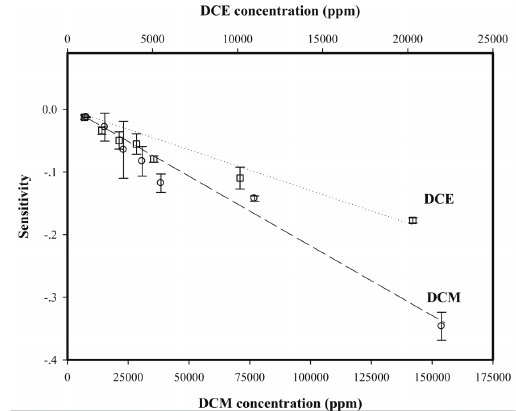
Figure 4. The sensitivity of D-PDPA/30%Y_H + [80] toward DCM and DCE at different concentrations at 27±1°C and 1 atm.